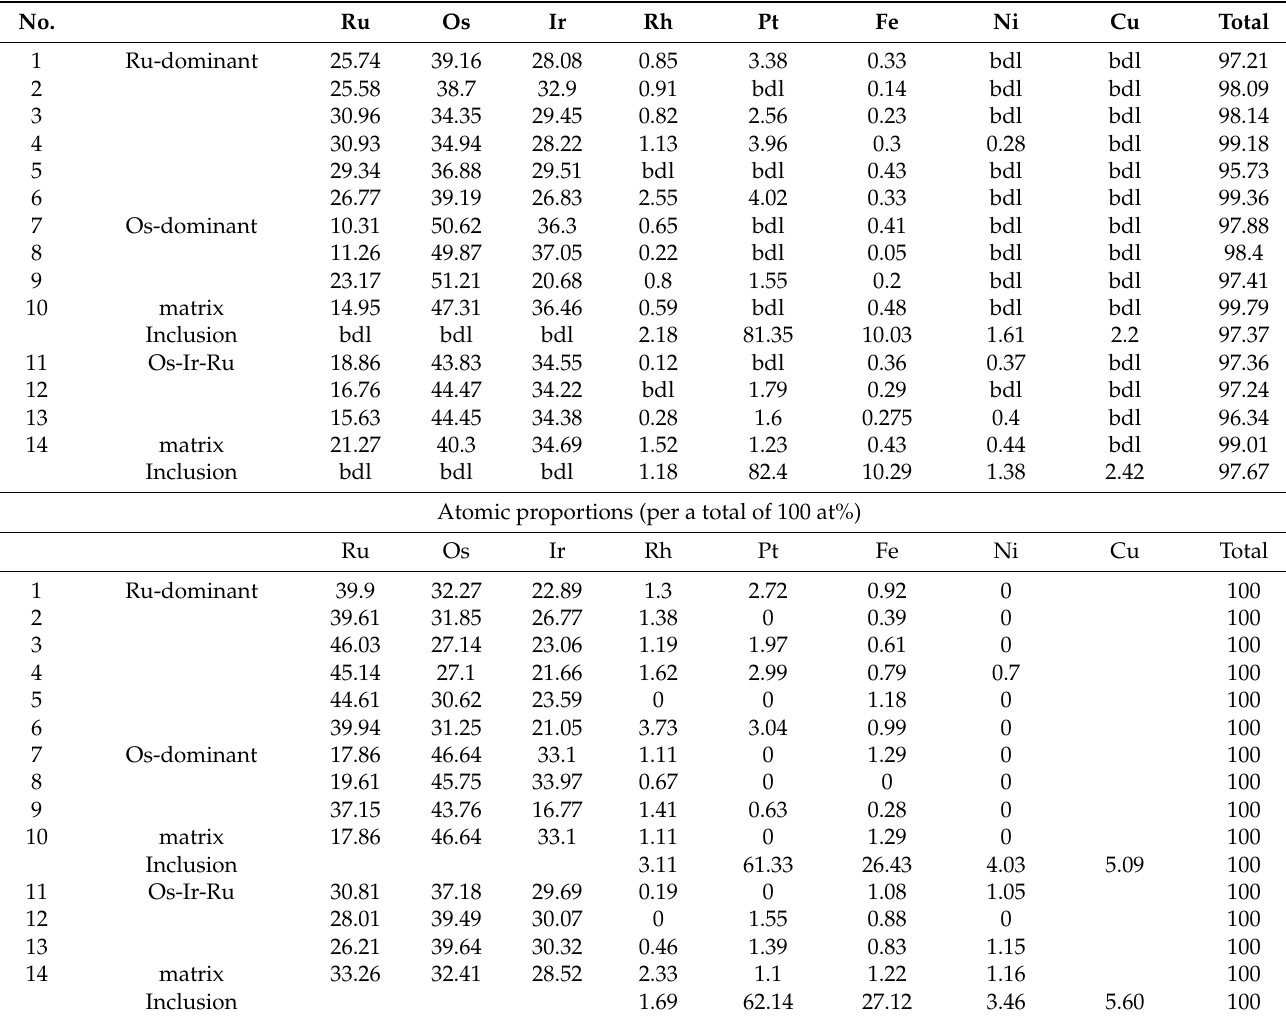
Table 1. Compositions of grains of Ru-Os-Ir alloy from the Placer of the Kitoy River